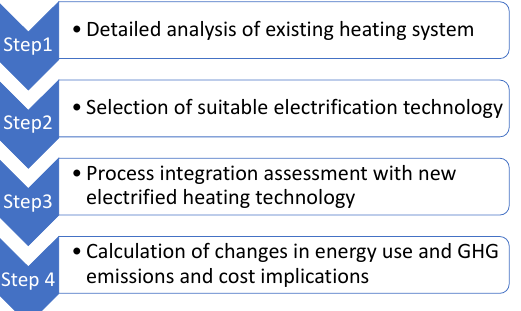
Figure 5. Methodology steps to estimate electrification potential in textile processes.